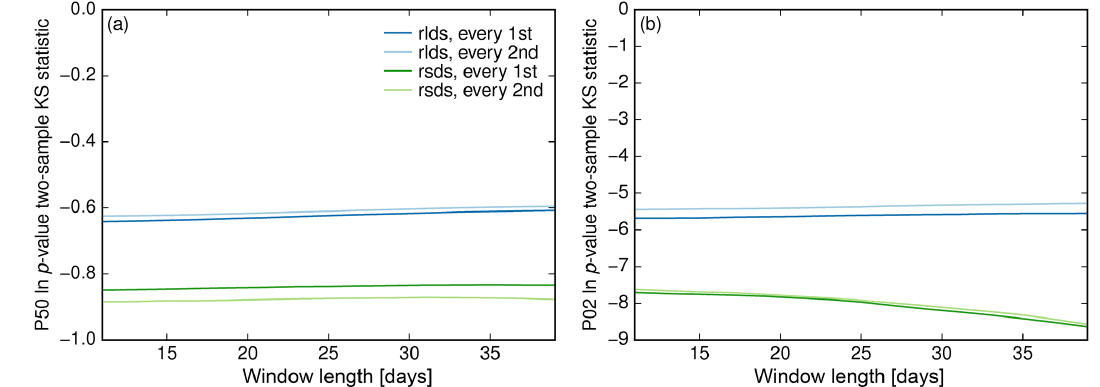
Figure D2. Dependence of two-sample KS statistic p values on window length for different radiation types and calibration data samples (see text and Fig. D1). Plotted are the grid-cell area-weighted 50th ( a ) and second ( b ) percentiles of the natural logarithms of the p values over months, latitudes, and